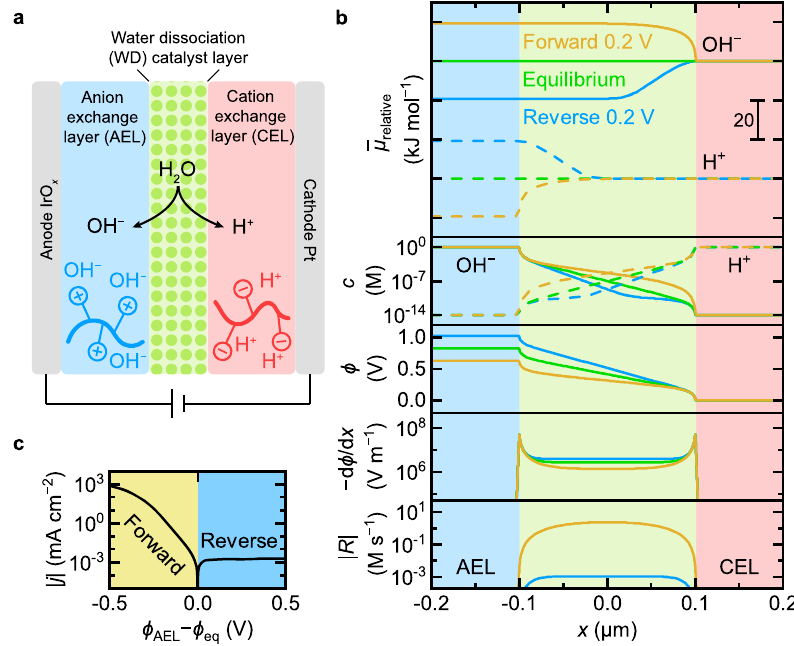
Fig. 1 Properties of BPMs. a Schematic of a BPM electrolyzer. Pure water is fed through the anode and cathode gas-diffusion layers (GDLs) and diffuses into the AEL|CEL junction where water is dissociated with the aid of WD catalysts. b Steady-state numerical simulation results of a BPM at equilibrium (green), in forward bias 0.2 V (orange), and in reverse bias 0.2 V (blue). From top to bottom are the pro fi les of relative electrochemical potential (cid:1) μ molar concentration c , electric potential ϕ , electric fi eld (cid:1) d ϕ = d x , and magnitude of the net reaction rate R j j (sum of dissociation and recombination). At equilibrium, the electrochemical potentials of each mobile species are the same across the whole BPM. c Simulated polarization curve of a BPM in forward bias and reverse bias. See Methods for more